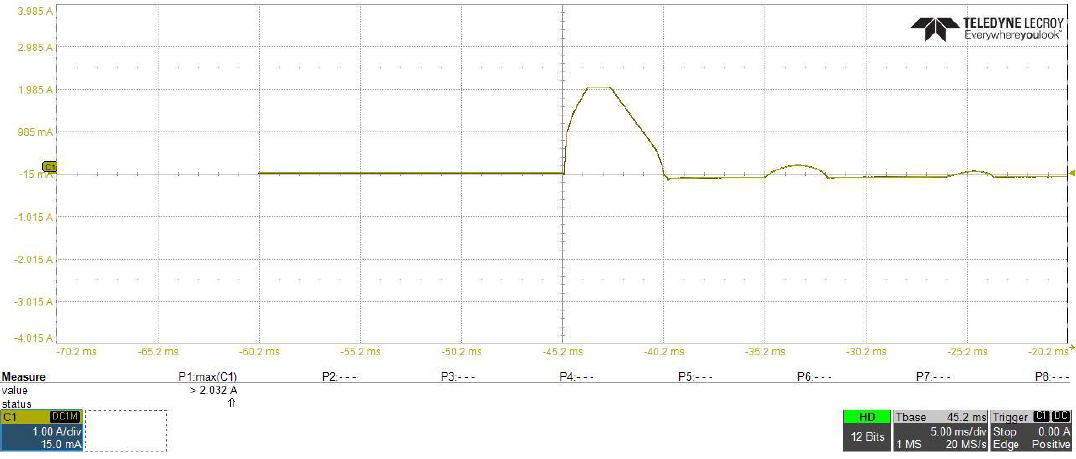
Figure 18. DC – DC converter stage input current without using of the proposed inrush current mitigation circuit.